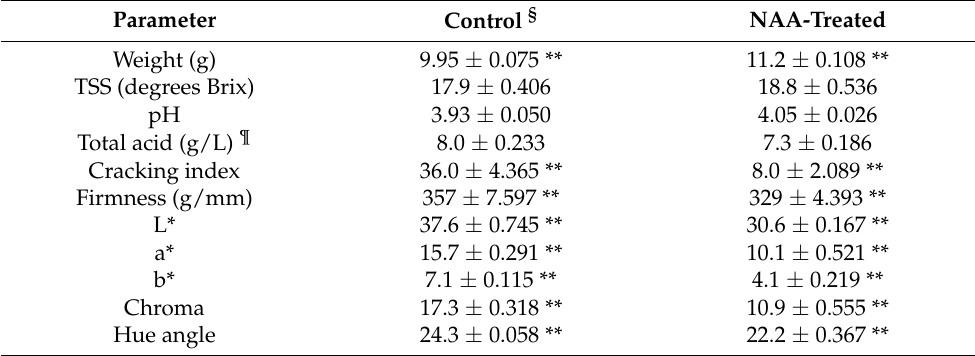
Table 1. Effect of pre-ripening NAA treatment on fruit maturity parameters at harvest (13 January 2020, 42 dps).